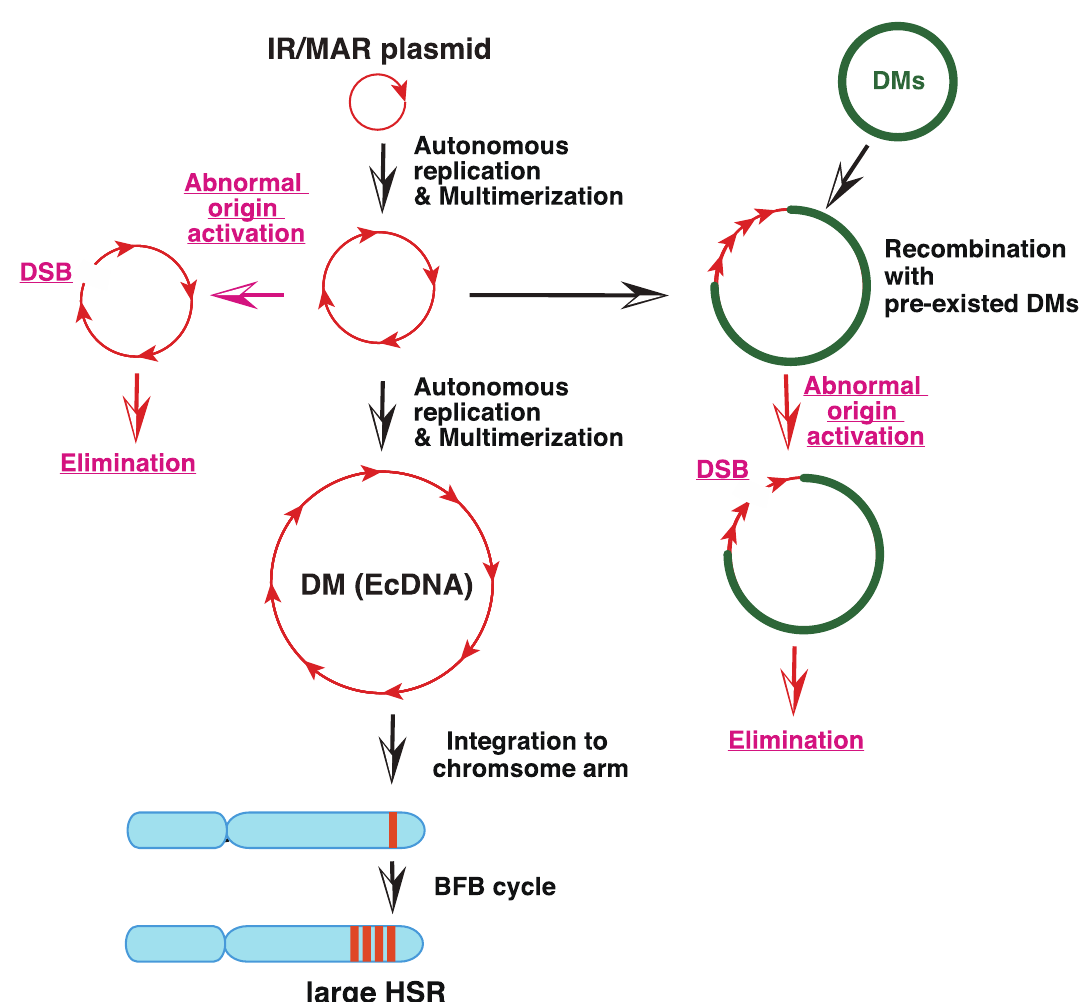
Figure 3. Mechanism of amplification of an IR/MAR-bearing circular plasmid. The IR/MAR plasmid is shown in red arrows. DMs, if pre-existed in the same cells, are shown in green, and the chromosome arm is shown in cyan. The processes in wild-type cells are indicated by black arrows, and the ones only in SIRT 1 knock-out cells are indicated by red arrows. Modified from Figure 7 of [44].